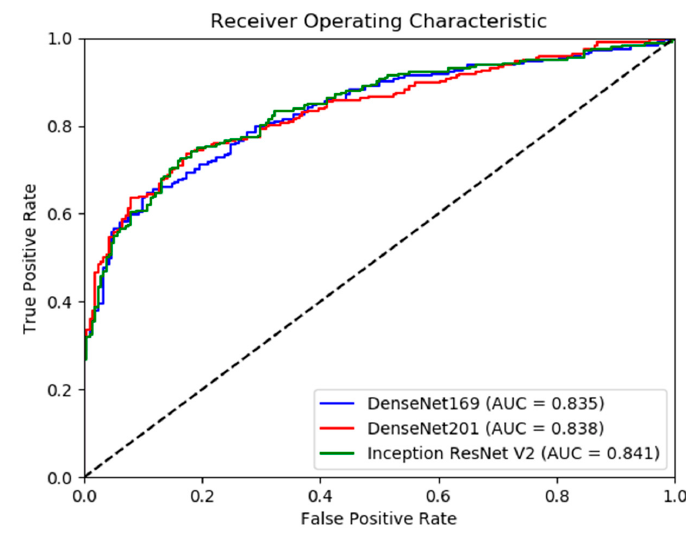
Figure 5. Model Receiver Operating Characteristic Curves—Finger.